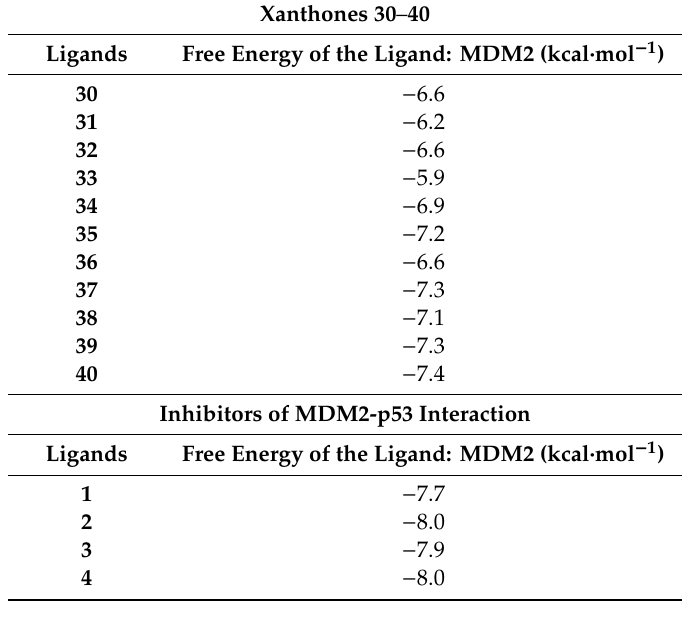
Table 1. Docking scores (kcal · mol − 1 ) of xanthones 30 – 40 and positive controls 1 – 4 onto MDM2 target.